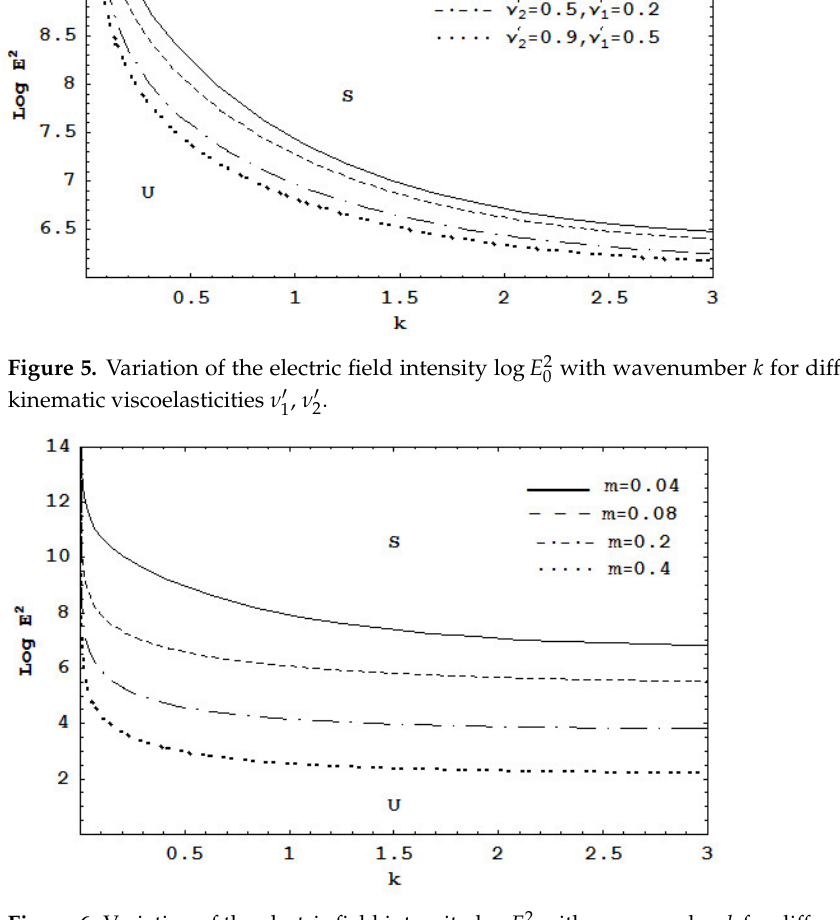
with wavenumber k for different values of the 0